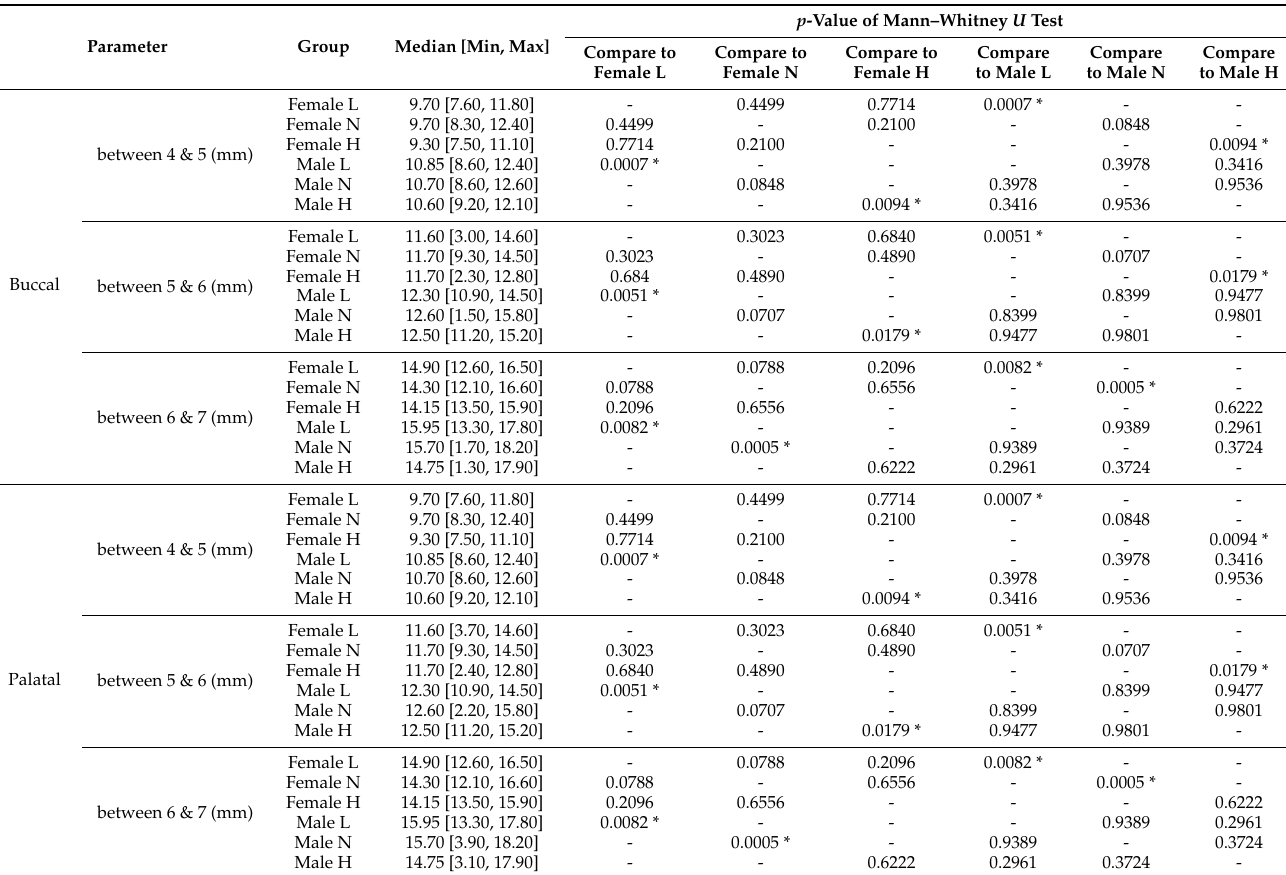
Table 5. The comparison of buccal and palatal alveolar bone thickness among groups at the level 5 mm above the alveolar crest. L: low-angle; N: normo-angle; H: high-angle. 4: first premolar, 5: second premolar, 6: first molar, 7: second molar. *: p <